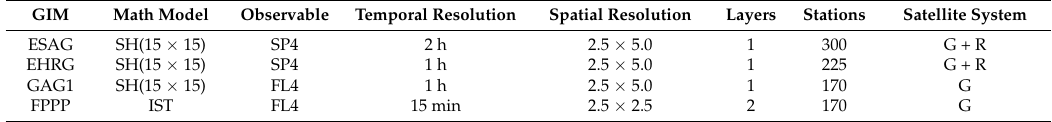
Table 2. The details of the global ionosphere models used for comparison.